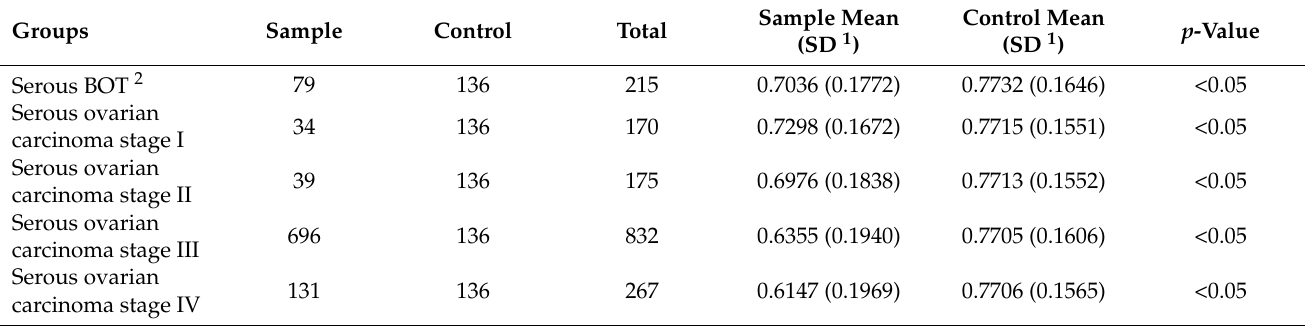
Table 1. Number of samples and statistics for the groups of serous BOTs and all FIGO stages of serous ovarian carcinomas.